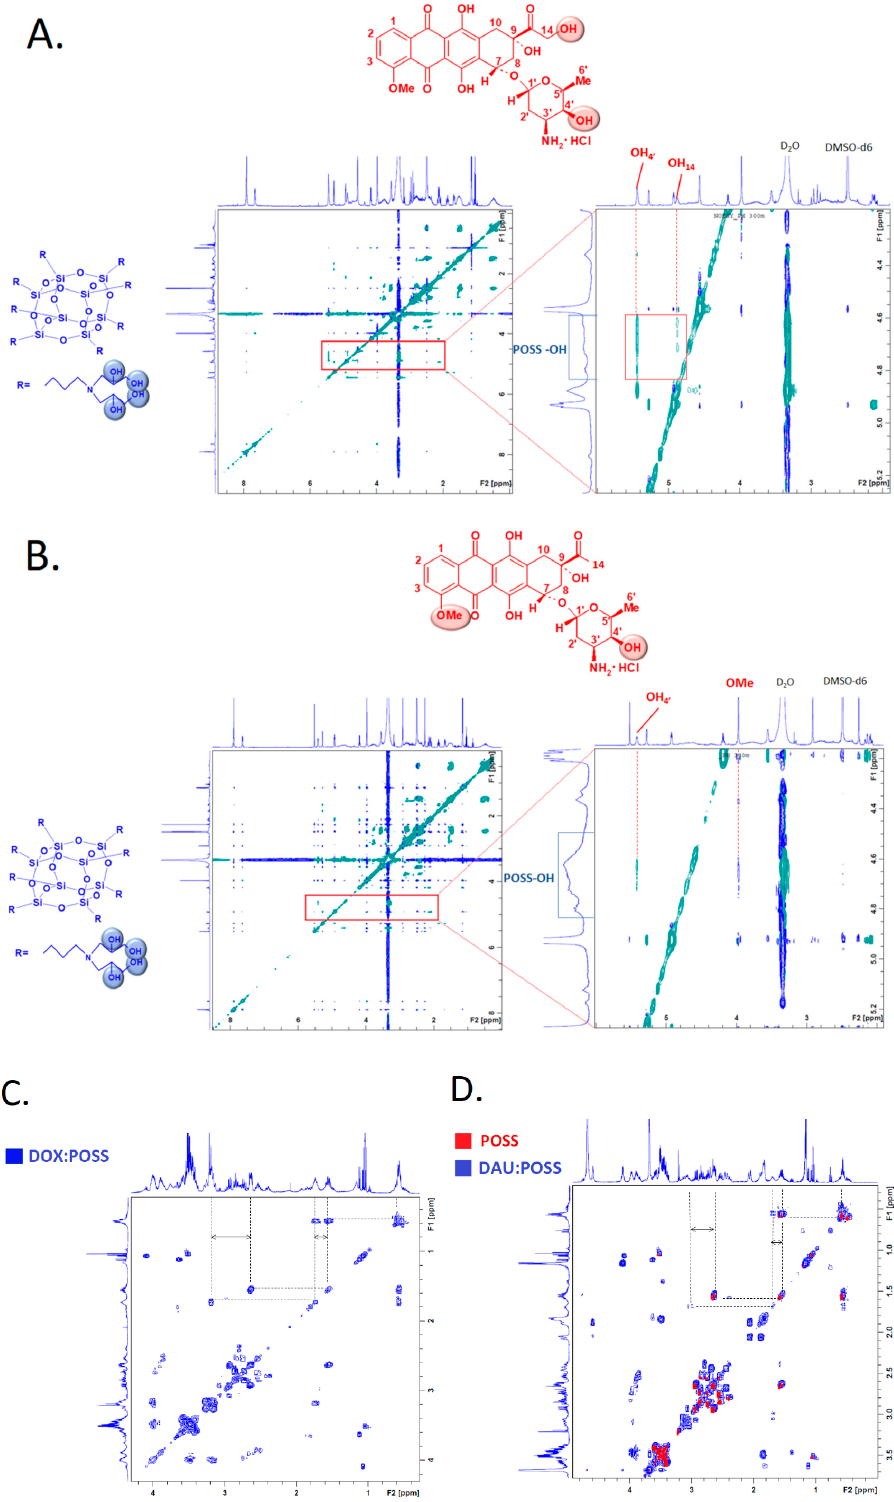
Figure 2. Two-dimensional nuclear Overhauser effect (2D NOESY) spectra of the DOX:POSS ( A ) and DAU:POSS ( B ) complexes in DMSO-d 6 (300 K, 500 MHz). The homonuclear correlation spectroscopy ( 1 H- 1 H COSY) spectra of DOX:POSS ( C ) and DAU:POSS ( D ) complexes, compared with POSS in D 2